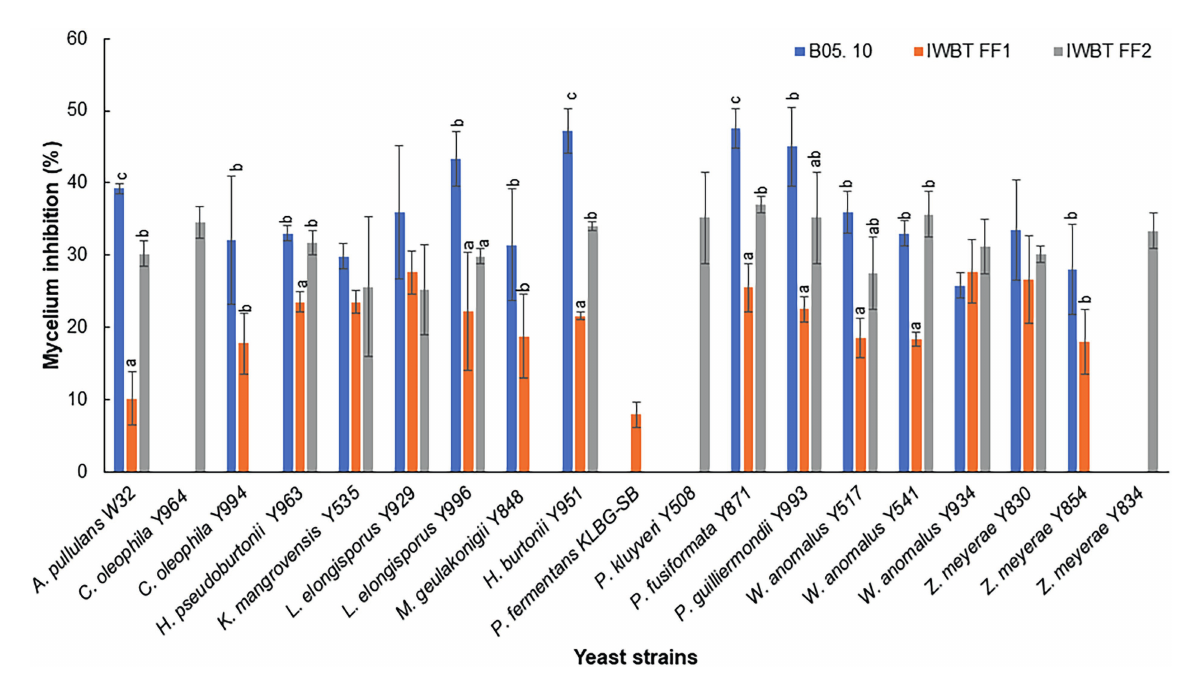
FIGURE 3 Yeast inhibition of Botrytis cinerea B05. 10, IWBT FF1 and IWBT FF2 mycelial growth. Bars represent average inhibitions of three replicates with standard deviation. Different superscript letters ( a, b, c ) show significant differences according to Tukey and Dunnett test ( p < 0.05) when comparing the mycelium inhibition of each B. cinerea strain by different yeasts. Strains with no superscript letters indicate those with no significant difference.